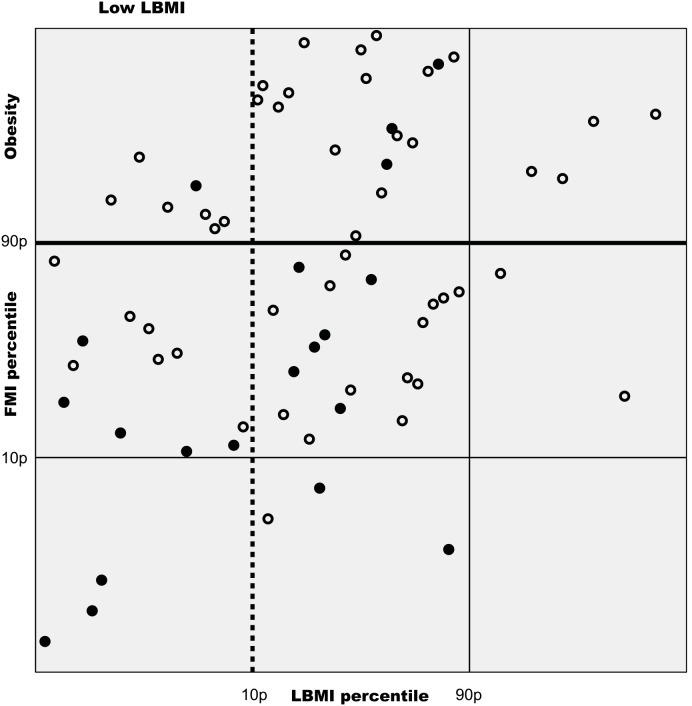
Non-linear plot of fat mass index (FMI) versus lean body mass index (LBMI) of maintenance dialysis patients (n = 68).Horizontal and vertical lines indicate 10th (10p) and 90th percentile (90p) of healthy reference population. Filled circles are patients classified as protein-energy wasted according to ISRNM criteria. The horizontal bold line separates obese individuals from the non-obese and the vertical dotted line separates individuals with low LBMI from the individuals with normal or high LBMI.